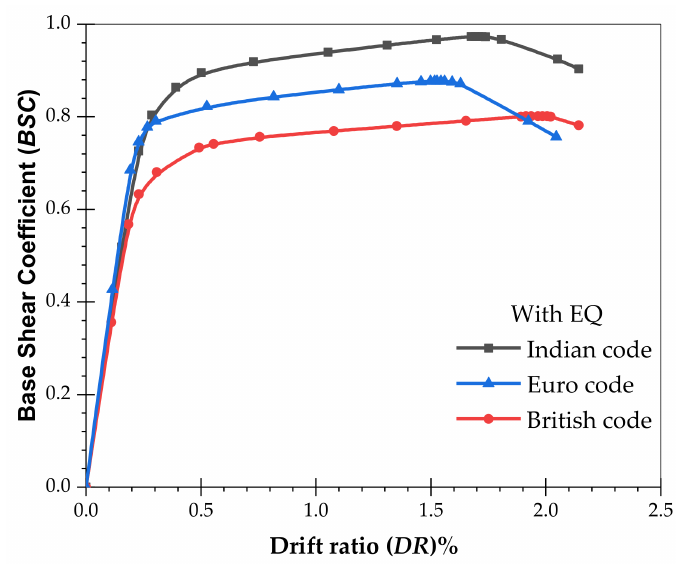
Figure 6. Base Shear Coe ffi cient versus Drift Ratio for with earthquake (WiEQ)